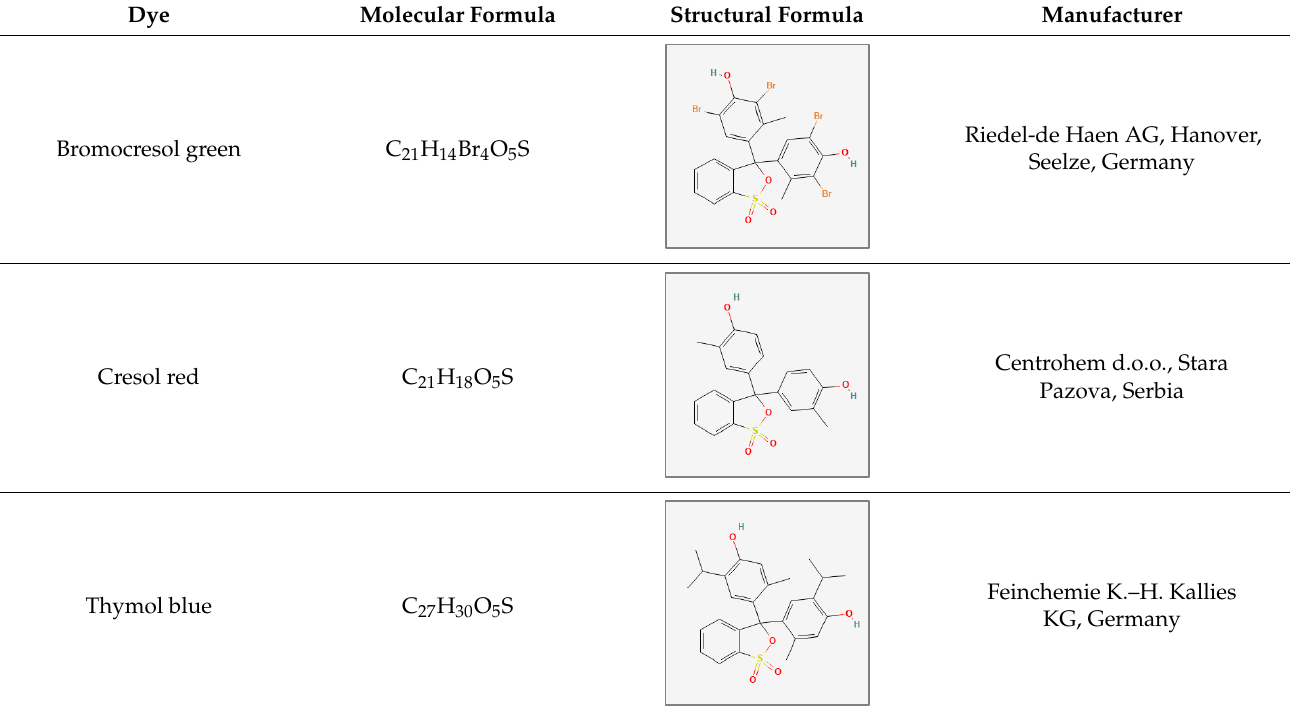
Table 1. Dyes used for preparation of electrolyzed mixture in 0.1 M Na 2 SO 4. Dye Molecular Formula Structural Formula Manufacturer